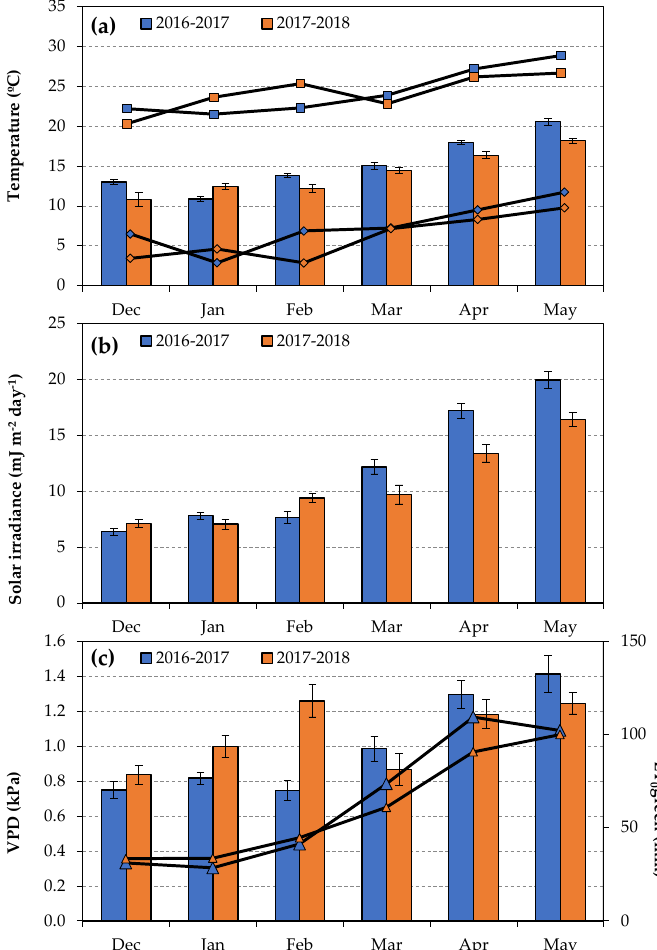
Figure 1. Monthly values of ( a ) mean, maximal (squares line patterns) and minimum (diamonds line patterns) temperature, ( b ) solar irradiance, ( c ) vapor pressure deficit (VPD) and potential evapotranspiration (ET 0green ; triangles line patterns) under the macro-tunnel during the 2016–2017 and 2017–2018 cropping season. Vertical bars represent the average (±SE).